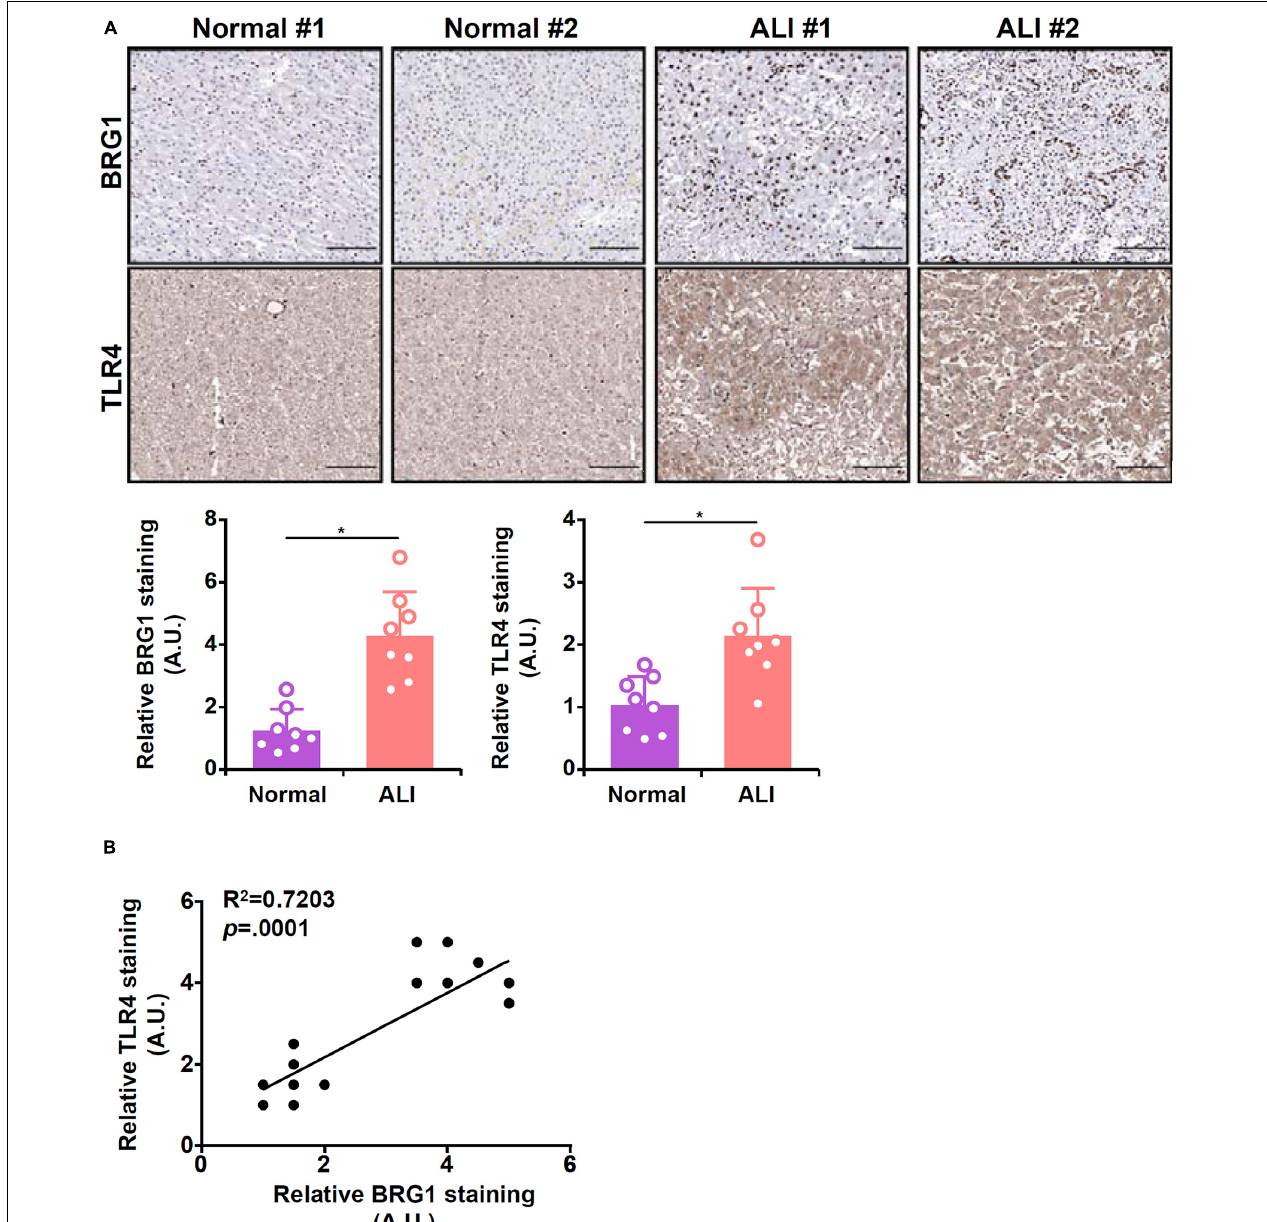
FIGURE 6 | Expression levels of BRG1 and TLR4 in human liver biopsy specimens. (A) Representative images of BRG1 and TLR4 staining in liver biopsy specimens of patients diagnosed with acute liver injury (ALI). (B) Linear regression was performed with Graphpad